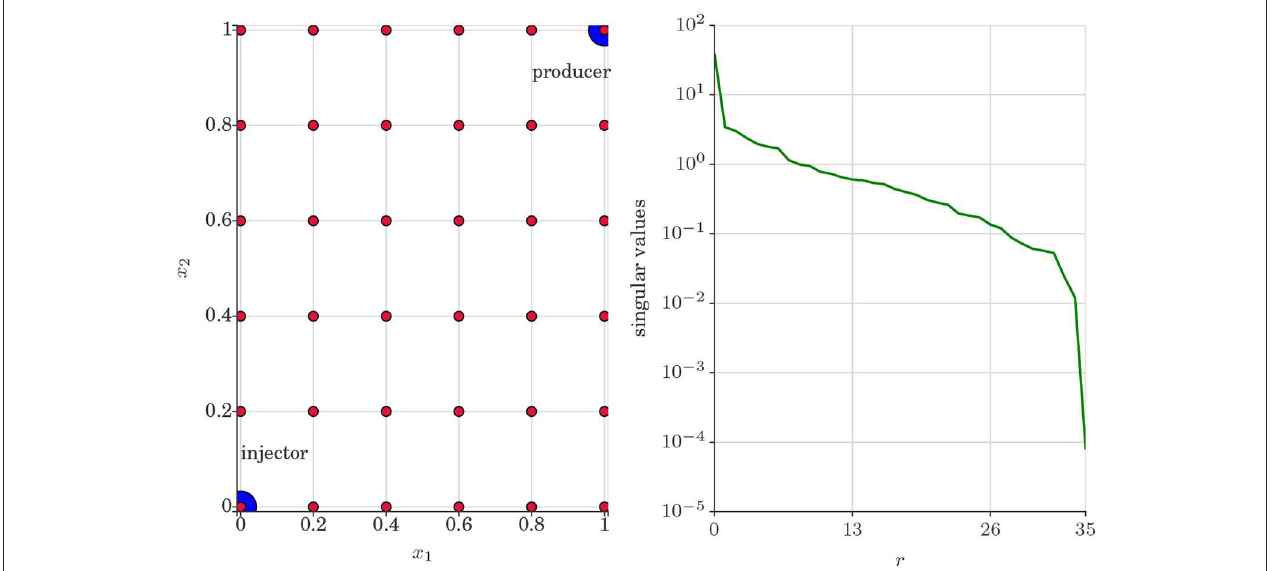
FIGURE 3 | Test case 1. (Left) Two dimensional quart-five spot problem set-up where water is injected in the lower left corner (blue dot). Oil is displaced and produced with water in the upper right corner (blue dot). The red dots denotes spatial locations in the porous media domain where the statistics of the QoI u are investigated. (Right) Decay of singular values of the snapshot matrix X u